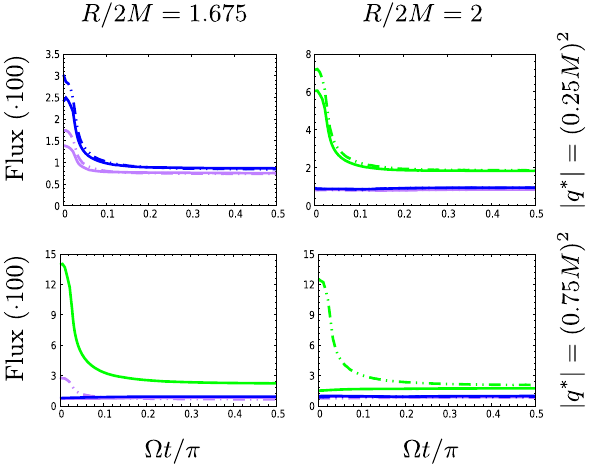
Fig. 9 Same configuration as in Fig.8 but for h = 0. We see that, for a constant plasma density, low frequencies do not satisfy the propagation conditions in the vicinity of the star